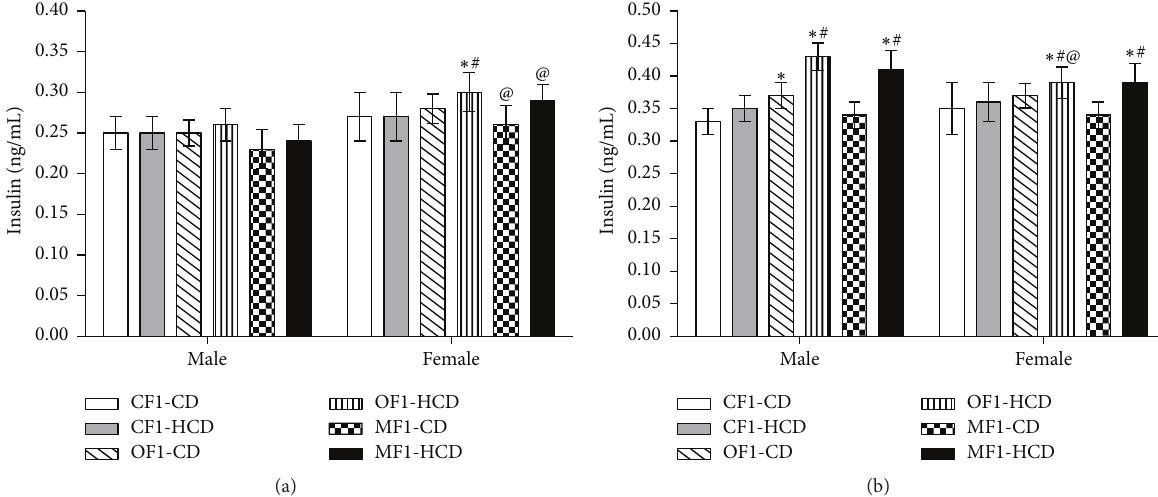
Figure 2: Serum insulin levels (ng/mL) of all study groups at (a) week 5 and (b) week 30 of age. Data are presented as mean ± SD ( 𝑛 = 10 ). CF1-CD: F1 offspring of control mothers under control diet, CF1-HCD: F1 offspring of control mothers under high-caloric diet, OF1-CD: F1 offspring of obese mothers under control diet, and OF1-HCD: F1 offspring of obese mothers under high-caloric diet; MF1-CD: F1 offspring of malnourished mothers under control diet and MF1-HCD: F1 offspring of malnourished mothers under high-caloric diet. The symbol ∗ indicates significant difference from CF1-CD by ANOVA ( 𝑝 < 0.05 ), the symbol # indicates significant difference from CF-HCD by ANOVA ( 𝑝 < 0.05 ), and the symbol @ indicates significant difference from male at each age by 𝑡 -test.